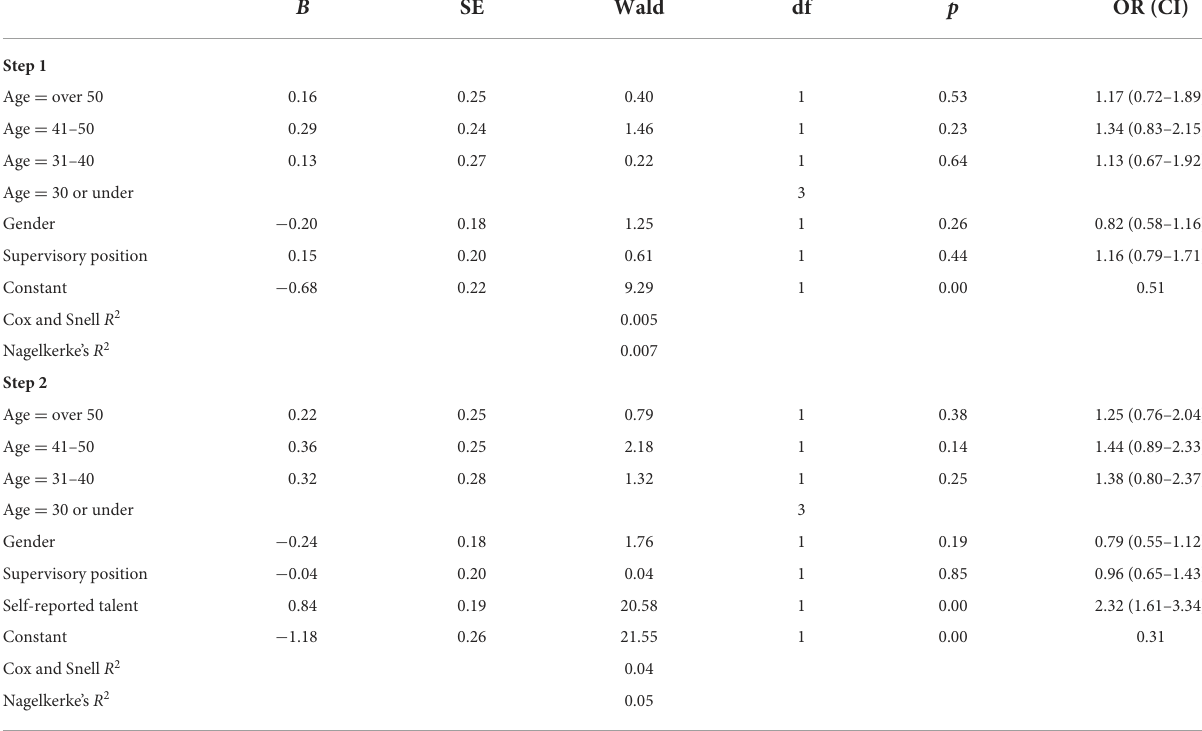
TABLE 2 Stepwise logistic regression Model 1: Perceived supervisor support regressed on socio-demographic control variables and self-reported talent ( N =